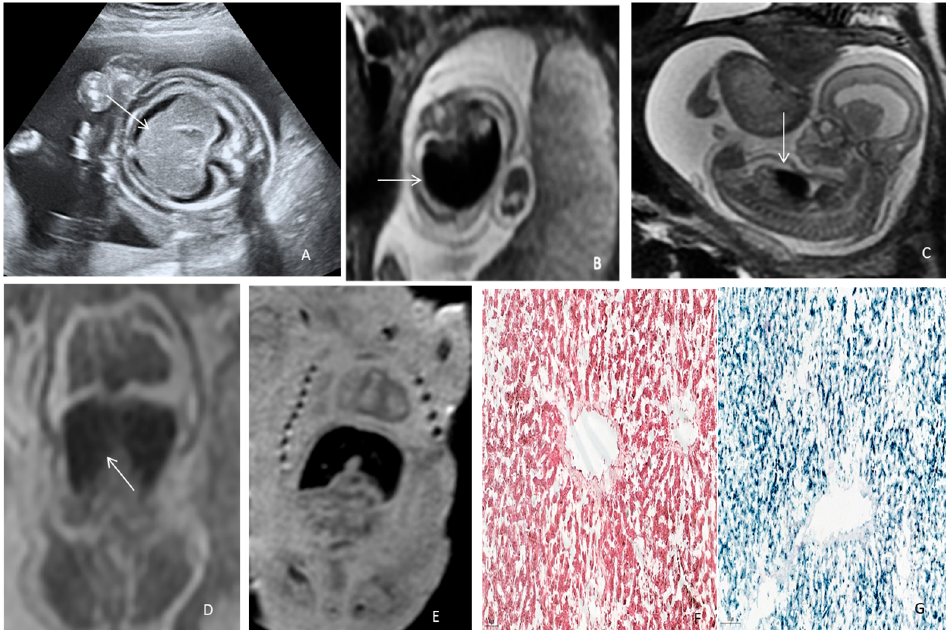
Figure 4 . Neonatal hemochromatosis in a hypotrophic fetus with idiopathic non-immune hydrops. ( A ) Ultrasound axial abdominal section depicting hepatosplenomegaly (arrow), ascites, and subcutaneous edema at 17 WGA. ( B ) Prenatal MRI 3T, T2 WI depicting fetoplacental anasarca and the liver with axial T2 hypersignal and ( C ) sagittal section (arrow) at 18 WGA. ( D , E ) Virtual autopsy using postmortem MRI, T2WI, and T1WI in the coronal plane depicting fetal liver with low signal (arrow), indicating the presence of iron at 21 WGA. ( F ) Hematoxylin–eosin staining (7×) showing two centrilobular veins and cords of hepatocytes. ( G ) Perls staining showing hemosiderin deposits (blue) in liver parenchyma (8×).